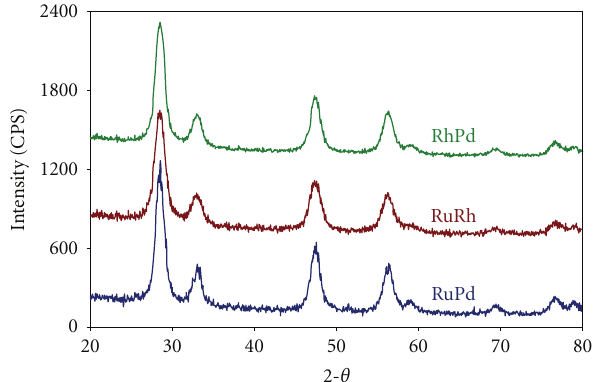
Figure 3: Sulfur-sorption characteristics of bimetallic catalysts during 24h soak at 800 ◦ C in 1000ppm H 2 S/bal. N 2